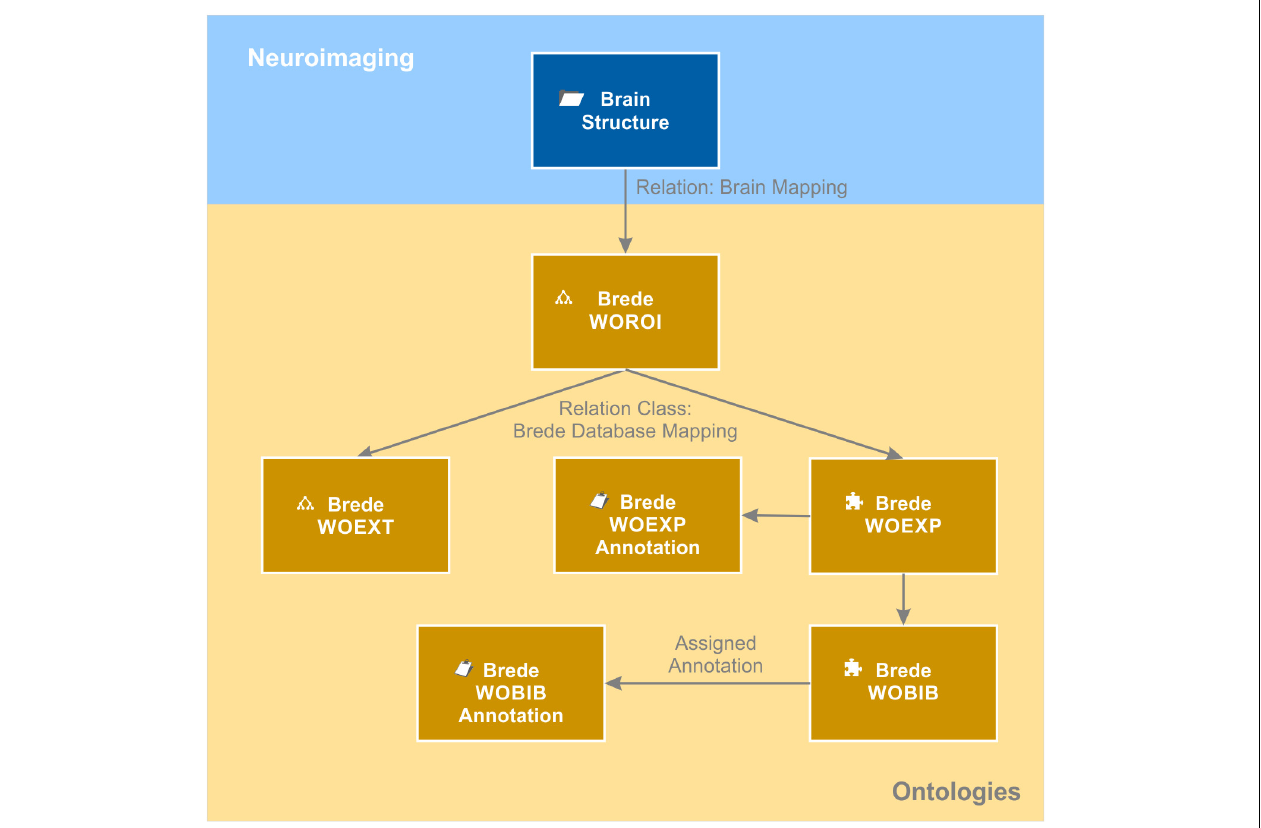
FIGURE 6 | Brain ontologies. Brain ontologies form a further sub-domain of the brain data knowledge model. The “brain structure” object that contains a repository of known brain structures is matched to structural and functional brain ontologies. The example shows a representation of the Brede database (Nielsen, 2003). The database consists of an ontology of brain structures (WOROI), an ontology of external components (WOEXT), and a list of cognitive experiments (WOEXP) that are further related to a list of literature references (WOBIB). Annotation objects indicated by the clipboard icon hold additional information such as the name of the cognitive tests (WOEXP annotation) or the PubMed ID of the cited paper and other meta-information (WOBIB annotation). Ontologies are indicated by the tree diagram icon while flat lists stored by the semantic object kind “element” are indicated by the puzzle